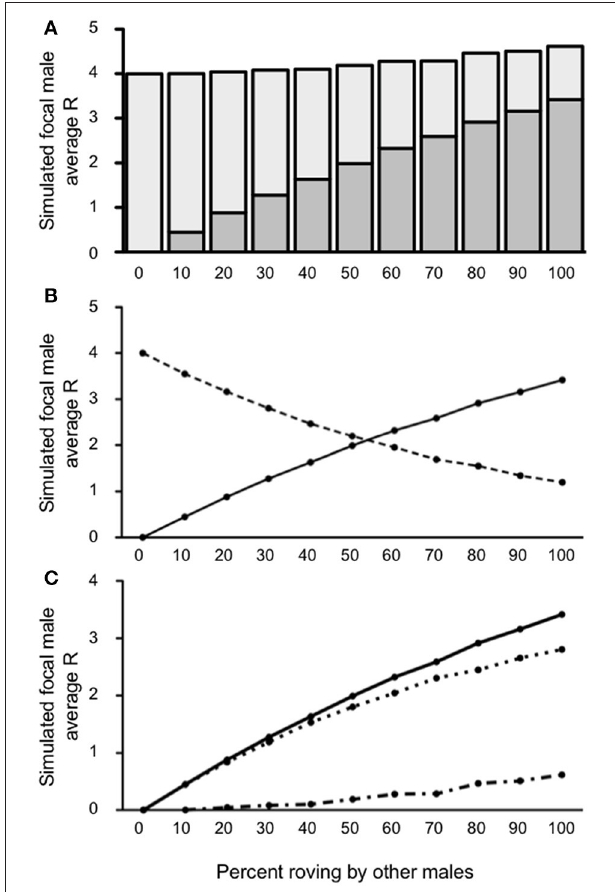
FIGURE 3 | Reproductive success for simulated roving focal male in Condition 1 at pair population 1,000. (A) Mean reproductive success (R) obtained by the simulated roving focal male at each percentage of roving in the population, split between R gained via extra-pair copulations (EPC; dark gray) and intra-pair copulations (IPC; light gray). (B) Average R gained via EPCs (solid line) and IPCs (dashed line) by the simulated roving focal male as the percentage of roving in the population increases. (C) Average R gained via EPCs ( E , solid line), average R lost via cuckolding ( C , dotted line), and total change in R ( 1 R, dash-dotted line) for the simulated roving focal male as the percentage of roving in the population increases.